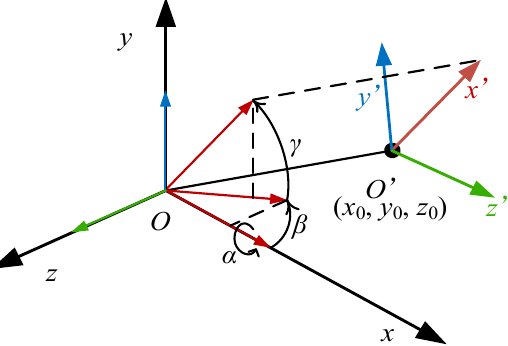
Figure 1. Transformation of material coordinate system.